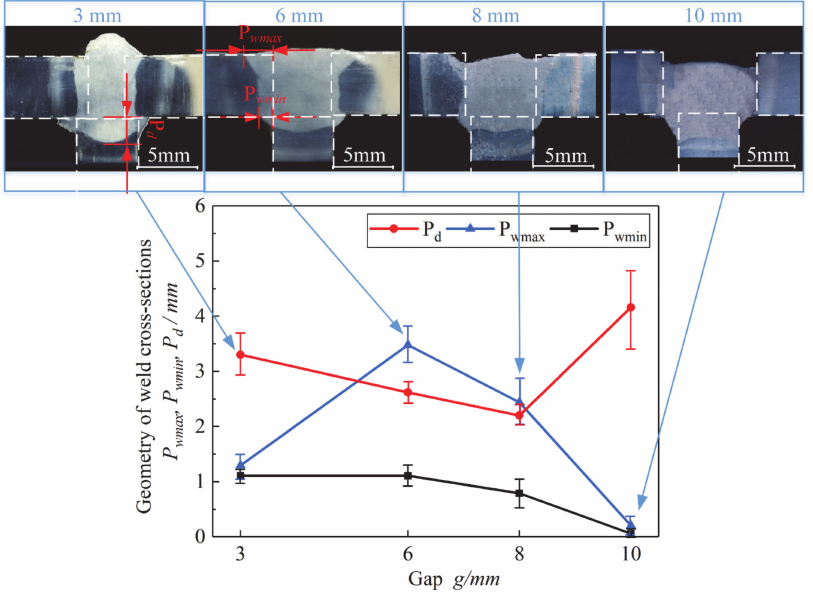
Figure 13. Weld cross-sections with di ff erent groove